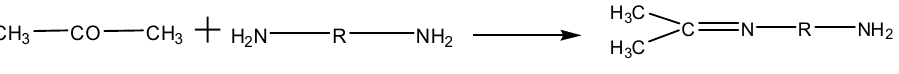
Scheme 8. Reaction of acetone with primary amine.